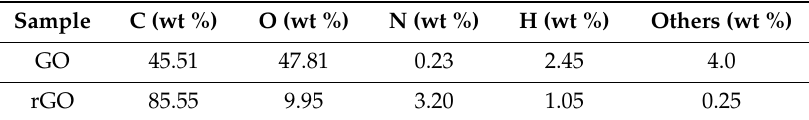
Table 1. Elemental composition of GO / rGO.